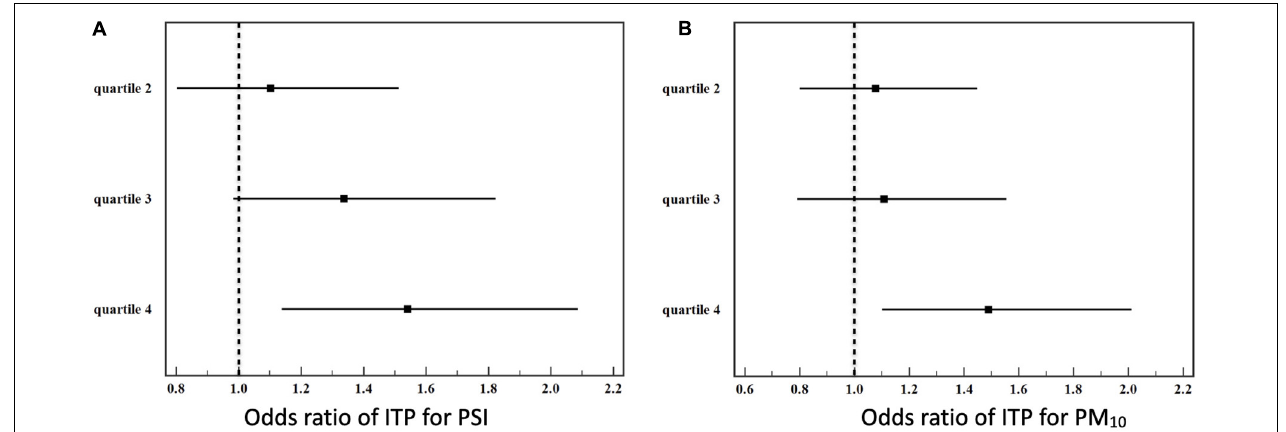
FIGURE 2 | Quartiles of prenatal cumulative air pollutant exposure to the risk of ITP. (A) Pollutant standard index (PSI), (B) PM 10